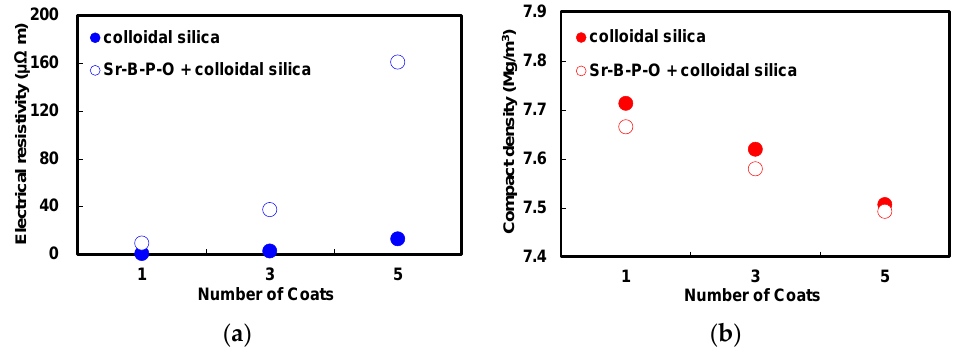
Figure 1. ( a ) Electrical resistivities; and ( b ) compact densities of the annealed toroidal cores fabricated from iron powder particles coated with colloidal silica with and without Sr-B-P-O insulating layers increasing number of silica coatings from 1–5.